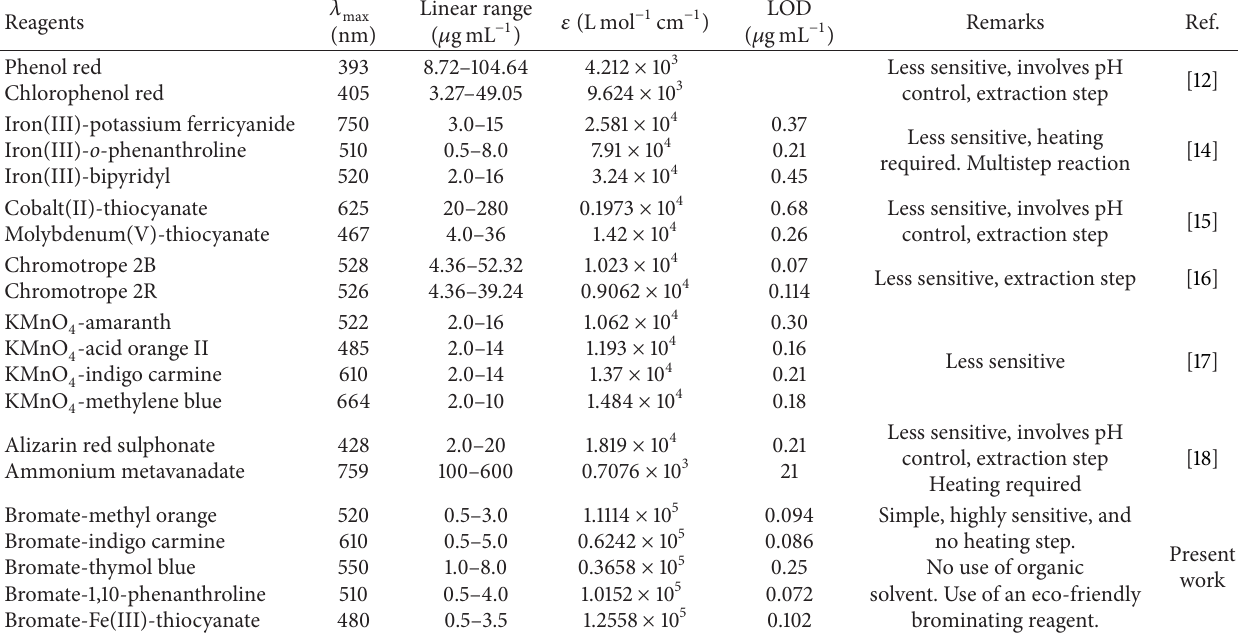
Table 1: Comparison of the proposed methods with the reported spectrophotometric methods for determination of PZT. Reagents